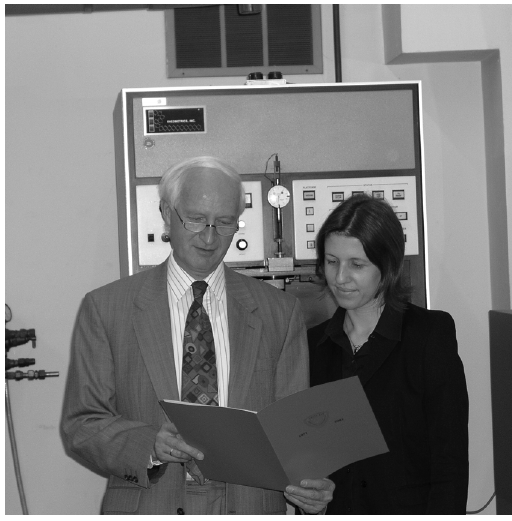
Figure 2 (left below): Young scientists rheology prize-winner (Rheologie- Preisträger 2003) Dr. Patrick Ilg with Prof. Mielke. Figure 3 (right middle): Young scientists rheology prize-winner (Rheologie- Preisträger 2003) Dr. Heike Bastian with Prof.